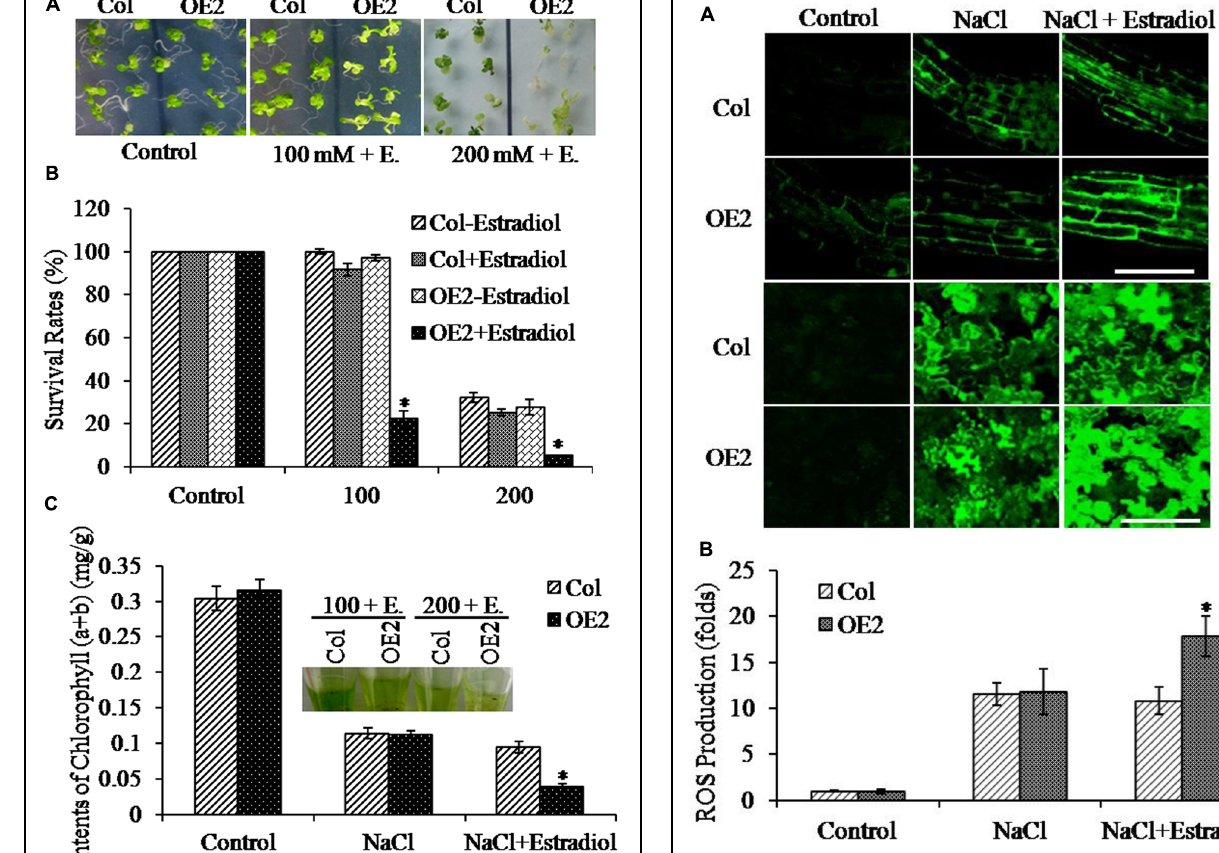
FIGURE 4 | Reactive oxygen species (ROS) production in roots and cotyledons was analyzed under NaCl treatment. The salt concentration was 100 mM in this assay. Estradiol, 10 μ M. Asterisk symbols ( ∗ ) indicate p < 0.05 (Student t- test). (A) The fluorescent intensity of DCF was observed with the confocal microscropy. Bar, 50 μ m. (B) The ROS contents in Col and OE2 plants were quantified. The data are means ± SE of three